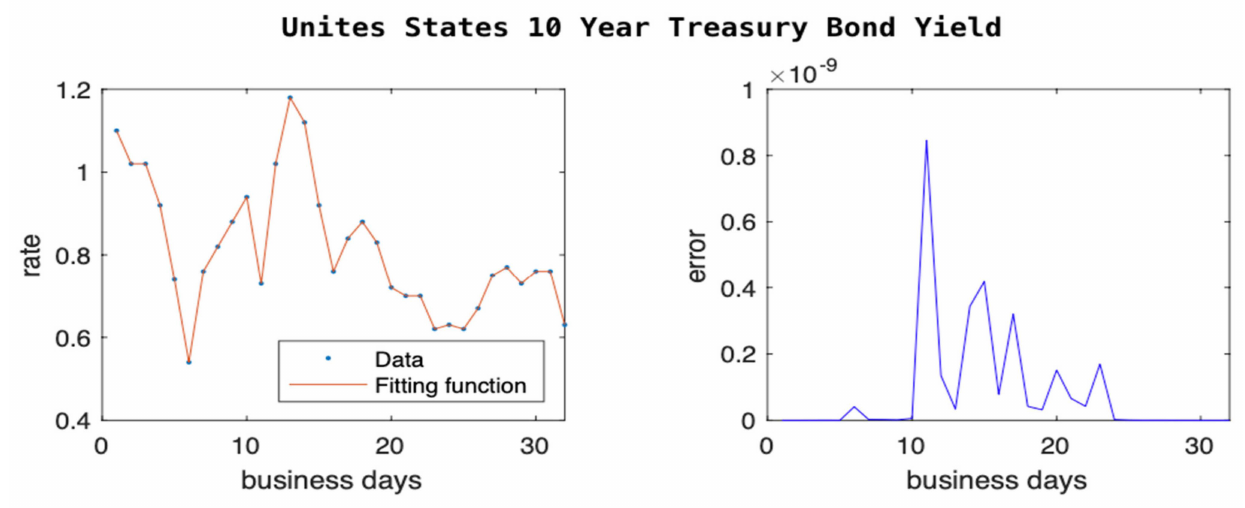
Figure 4. Fitting 10-year treasury bond rate from 1 March 2020 to 15 April 2020. N = 60, error range is [0, 8.459 × 10 − 10 ].